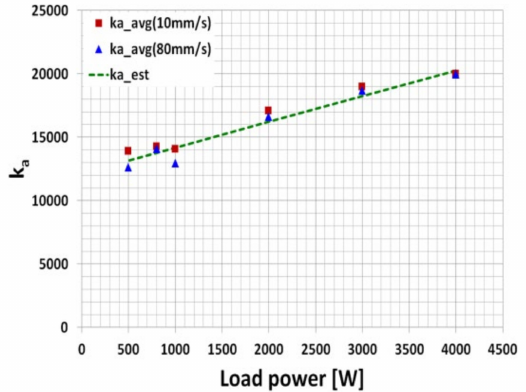
Figure 8. Average experimental value and estimation curve of arc empirical constant k a according to load power level (Source voltage ≥ 200